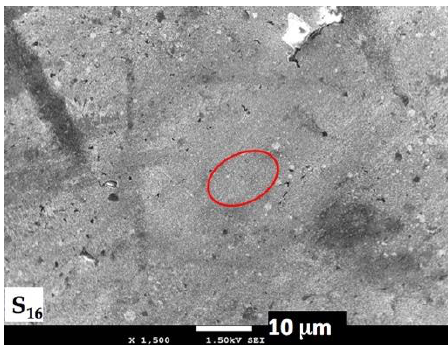
Figure 8. SEM micrograph for the irradiated spot S 16 at per-pulse laser fluence 1.4 mJ/cm 2 and 3 min exposure time.